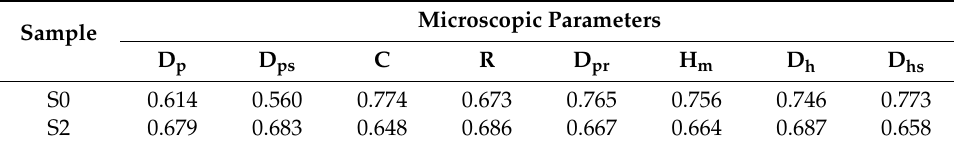
Table 7. Correlation between microscopic parameters and internal friction angle.